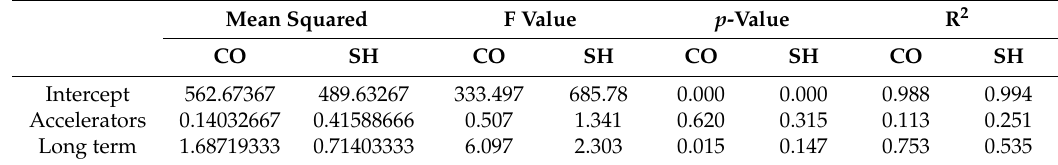
Table 6. Flexural strength ANOVA test.